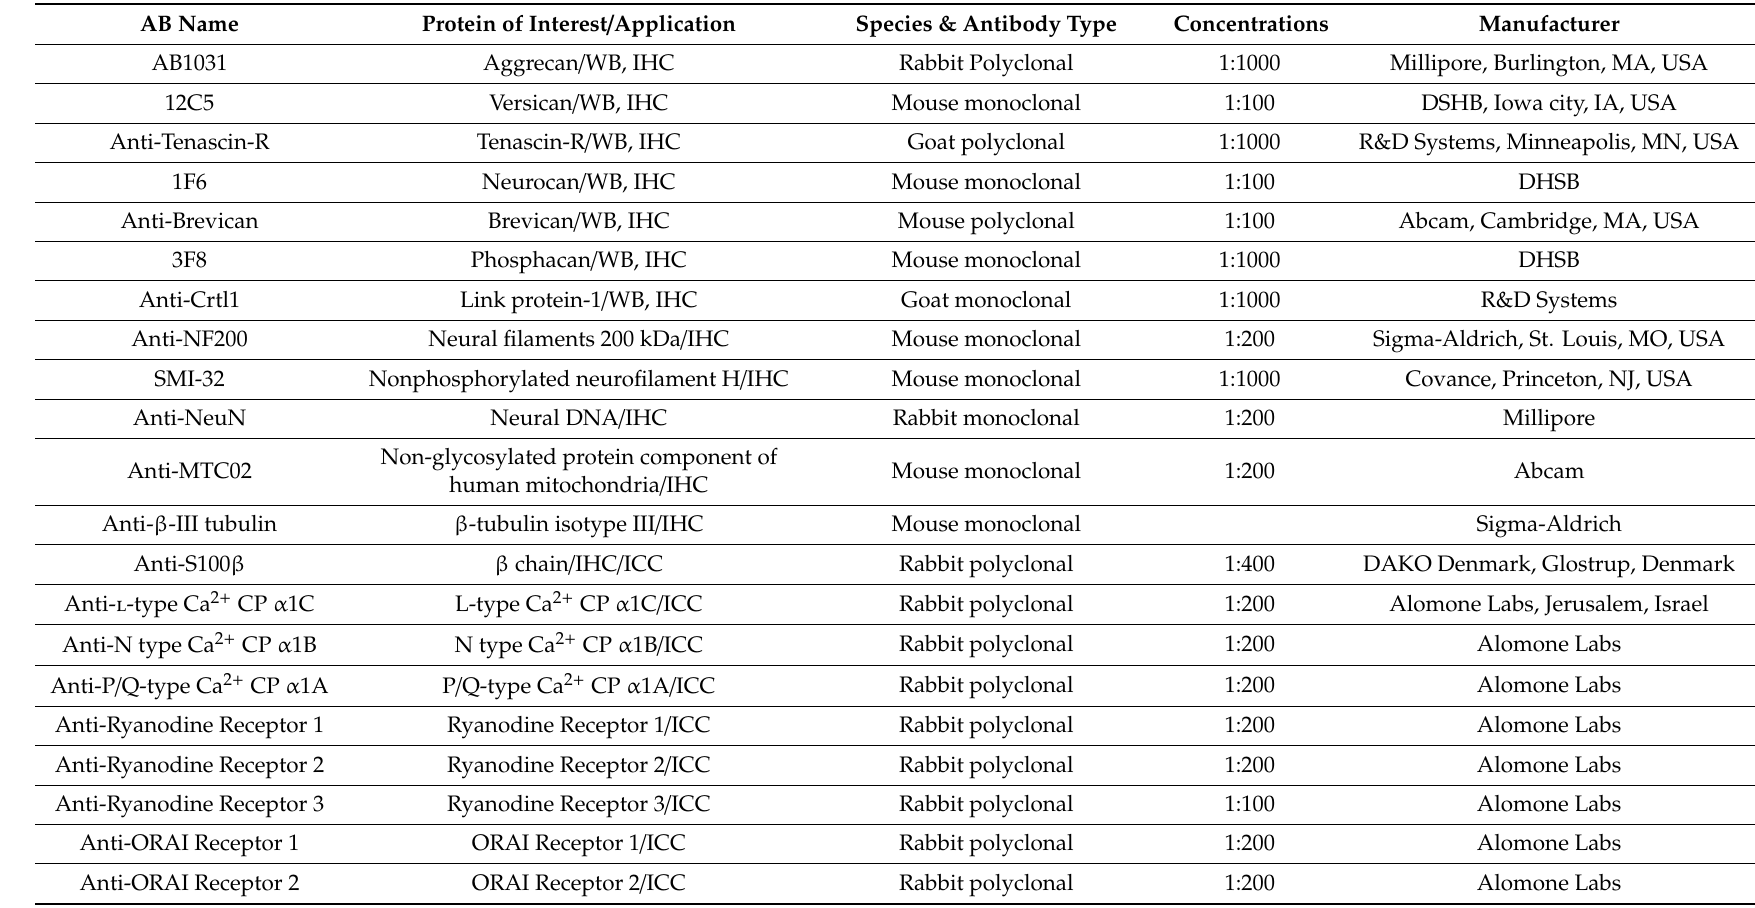
Table A3. List of primary